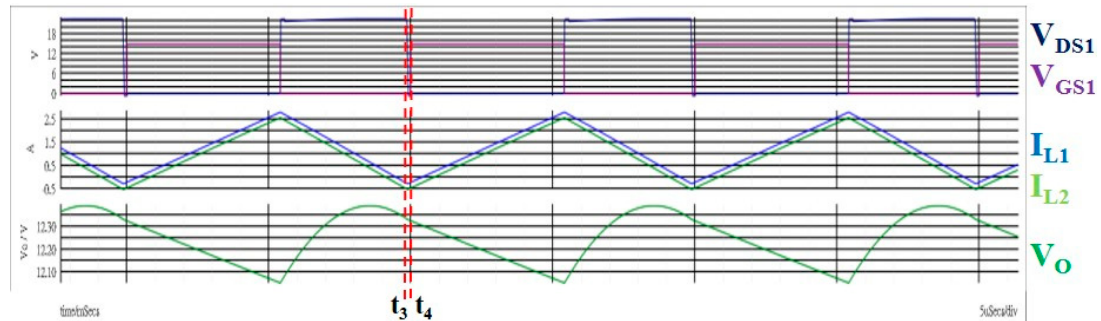
Figure 13. V GS 1 , V DS 1 , I L 1 , I L 2 , V 0 of input 10 V.